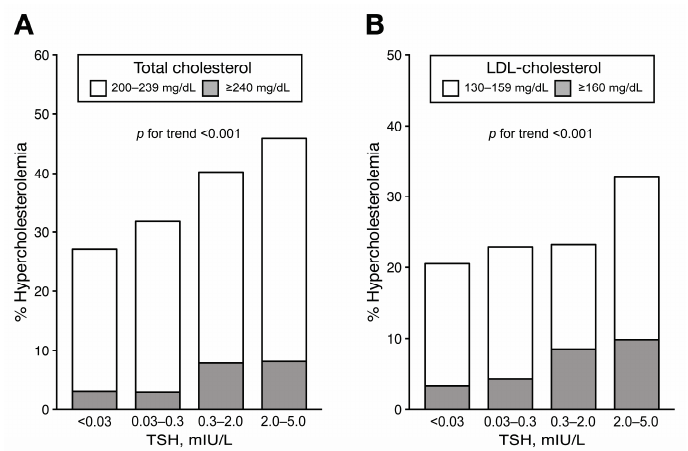
Figure 2. Prevalence of hypercholesterolemia at follow-up according to TSH group. (A) Prevalence of hypercholesterolemia defined as total cholesterol level of 200–239 and ≥240 mg/dL. (B) Prevalence of hypercholesterolemia defined as LDL-cholesterol level of 130–159 and ≥160 mg/dL. p for trend by Mantel-Haenszel test. LDL, low-density lipoprotein; TSH, thyroid-stimulating hormone.